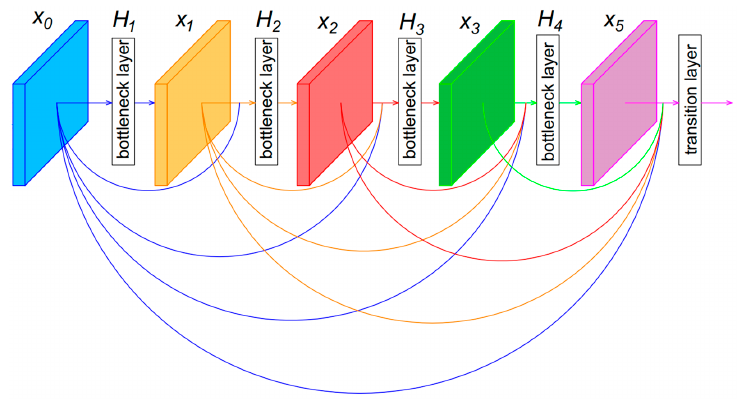
Figure 4. Dense block example.